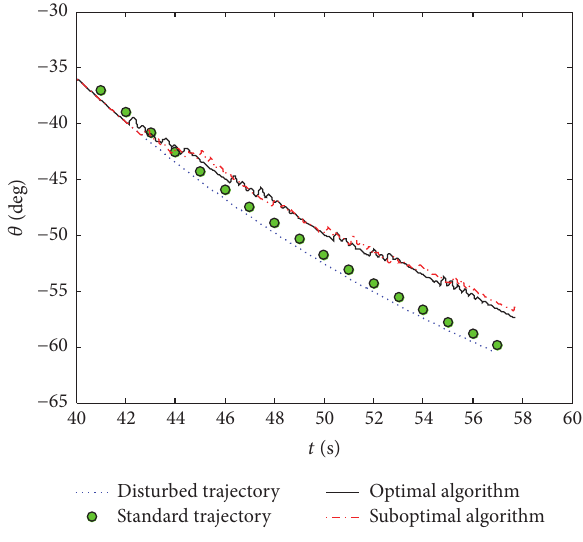
Figure 11: History between 𝜃 and 𝑡 .